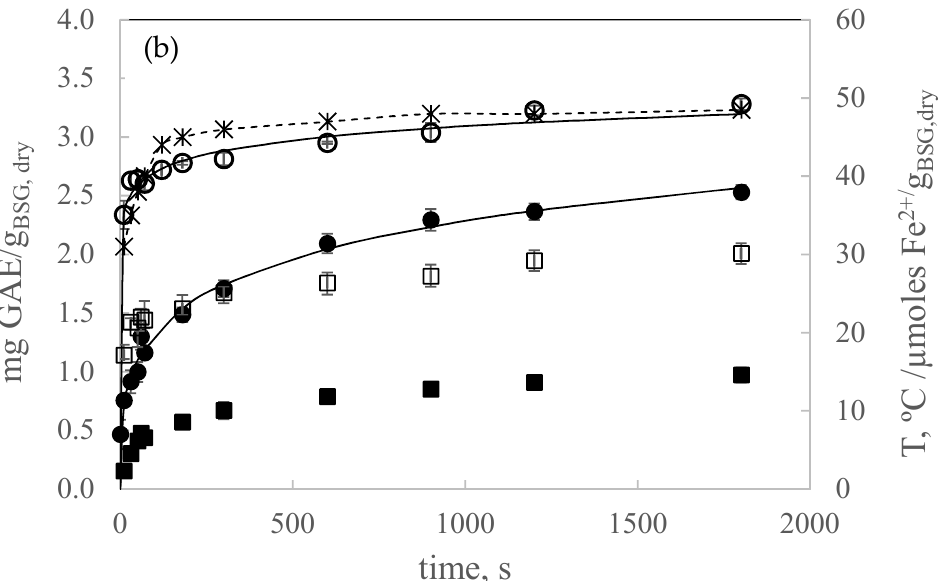
Figure 1. Total polyphenol content (TPC) water extraction kinetics at 47 ◦ C and 21.7 mL: g BSG,dry Figure 1. TPC water extraction kinetics at 47 °C and 21.7 mL:g dry BSG (a) mechanical stirring extraction ( a ) mechanical stirring extraction ( ∆ ground, (cid:78) non ground) ( b ) UAE ( ground, • non ground). (Δ ground, ▲ non ground) (b) UAE ( ○ ground, ● non ground). The secondary axis represents the (cid:35) The secondary axis represents the reducing power of the extracts as determined by the FRAP assay reducing power of the extracts as determined by the FRAP assay ( □ ground, ■ non ground ) and the ( (cid:3) ground, (cid:4) non ground) and the temperature profile along UAE extraction ( × ). Continuous lines temperature profile along UAE extraction (  ). Continuous lines represent the Weibull model. represent the Weibull